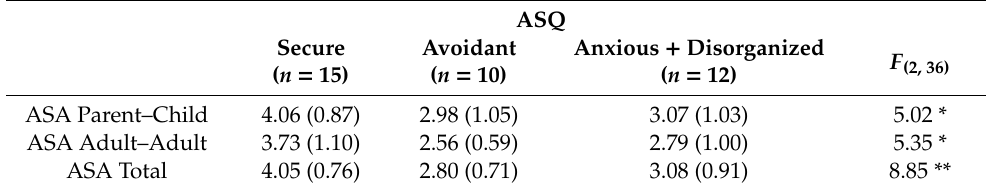
Table 3. Means (SD) for attachment (ASA) for the di ff erent attachment style questionnaire (ASQ) attachment